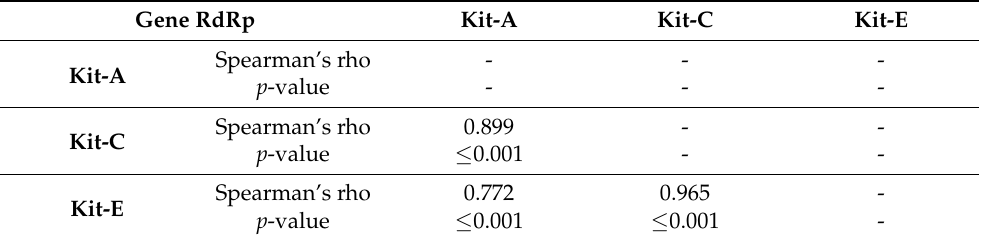
Table 7. Correlation matrix of three commercial kits targeting gene